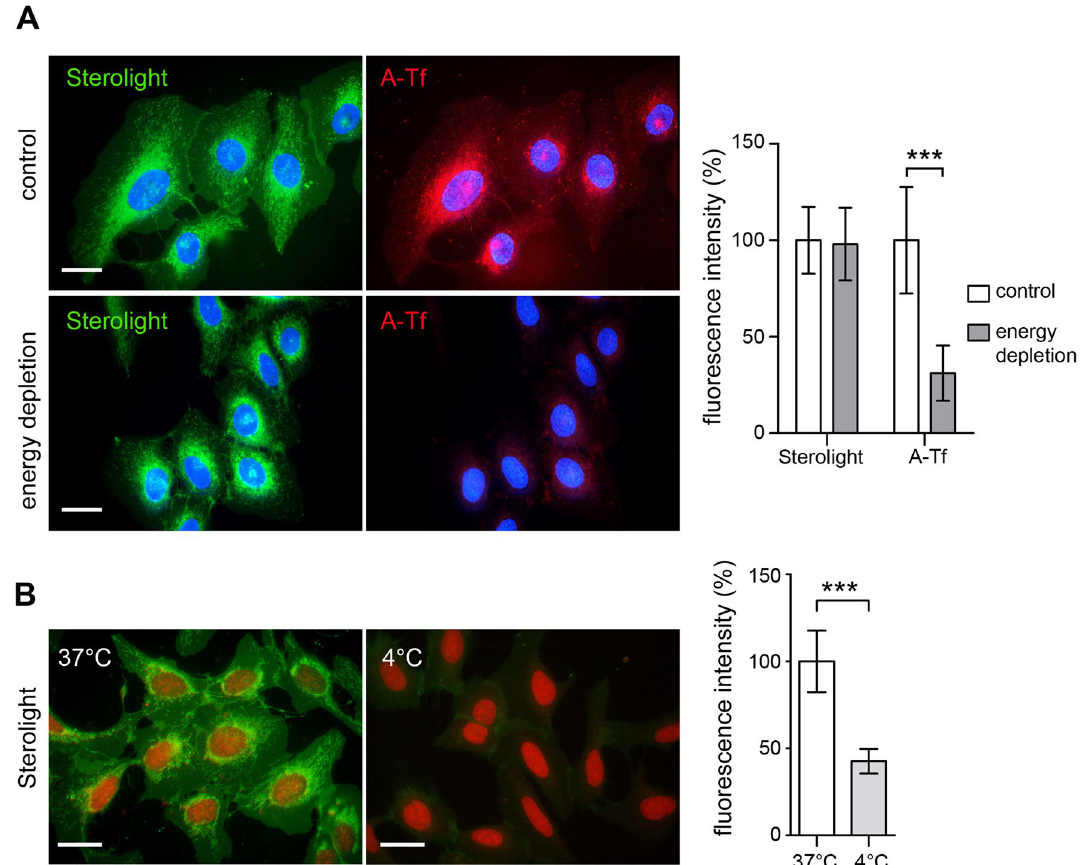
Figure 3. Energy depletion does not lead to suppression of Sterolight uptake. ( A ) U-2 OS cells were energy- depleted by incubation in M2 medium containing energy poisons (50 mM 2-deoxyglucose and 5 mM sodium azide) for 30 min at 37 °C, then pulsed with Sterolight probe (1 µg/ml) for 1 min and chased for additional 30 min in medium containing Alexa 568-transferrin conjugate ( A-Tf ). For last 5 min, Hoechst was added to stain the nuclei. Control cells were incubated in M1 medium containing glucose without energy poisons. The cells were imaged live, and the mean Streolight and Alexa-transferrin fluorescence intensity (%) was evaluated in control or energy-depleted cells. The bars represent mean ± SEM, and number of cells is 10–15. ***p < 0.001 between control and energy-depleted cells. While influx of Alexa 568-transferrin in energy-depleted cells was significantly reduced by energy poisons, Sterolight fluorescence remained unchanged. ( B ) Uptake of Sterolight in the cultivation medium with 5% LPDS was strongly reduced (p < 0.001) at 4 °C. Cell nuclei were stained with Draq5. Scale bar 10